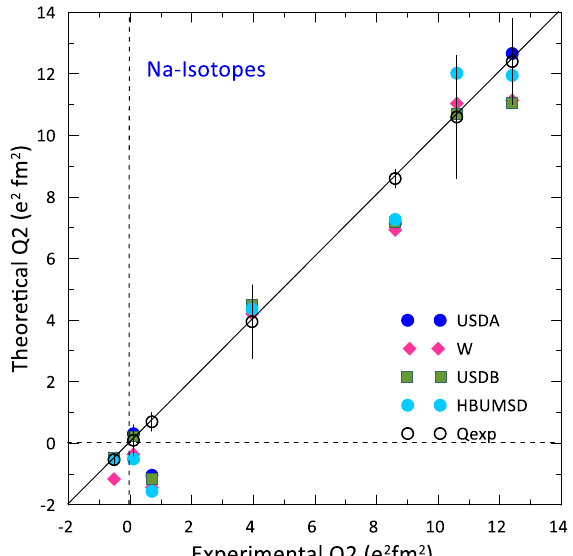
Figure 5: The calculated electric quadrupole moments Q2 (e 2 fm 2 ) vs the experimental data [16, 17] for Na-isotopes using different two-body effective interactions; USDA, USDB, HBUMSD and W.